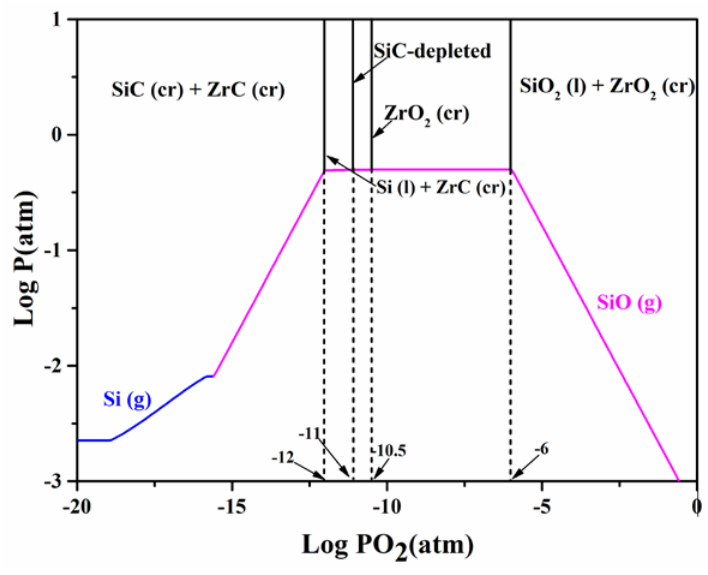
Figure 14. Volatility diagram for the ZrC–SiC system at 2300 °C.